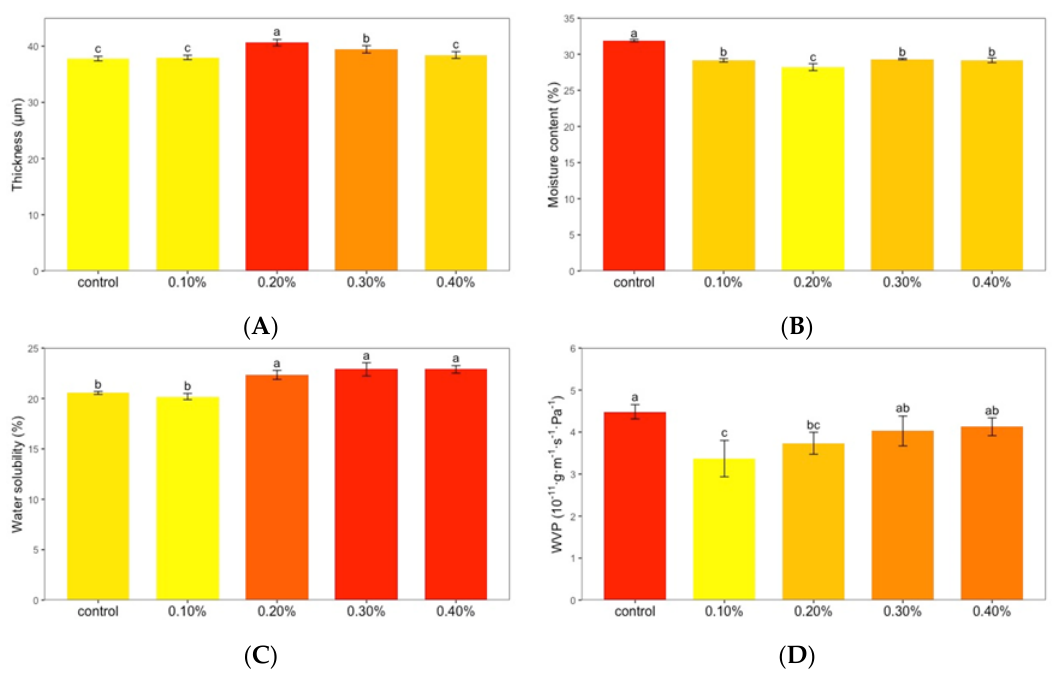
Figure 4. Thickness ( A ), moisture content ( B ), water solubility ( C ), WVP ( D ) of films. Control represents the chitosan film without pectin.